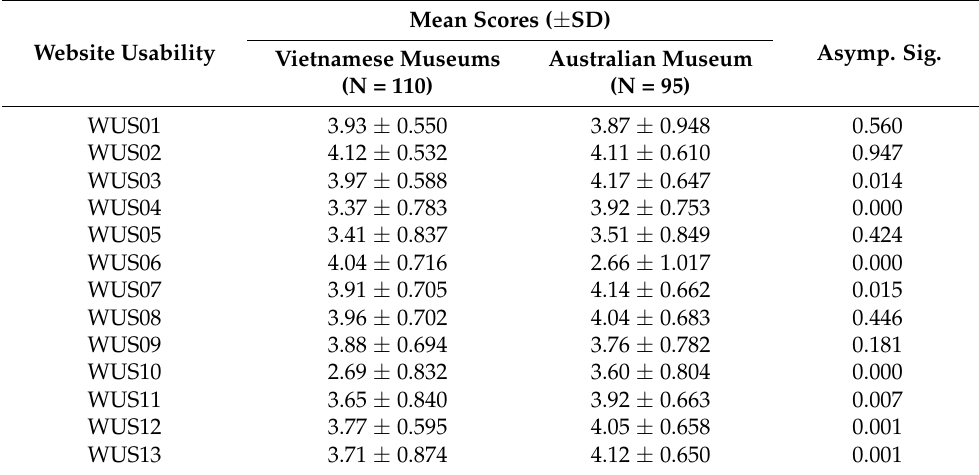
Table 7. Usability evaluation of websites: Mean, SD, and p -value. Website Usability